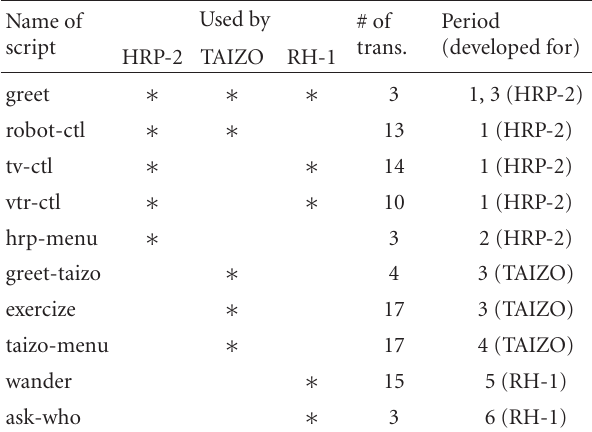
Table 1: Scripts used by each application and its development